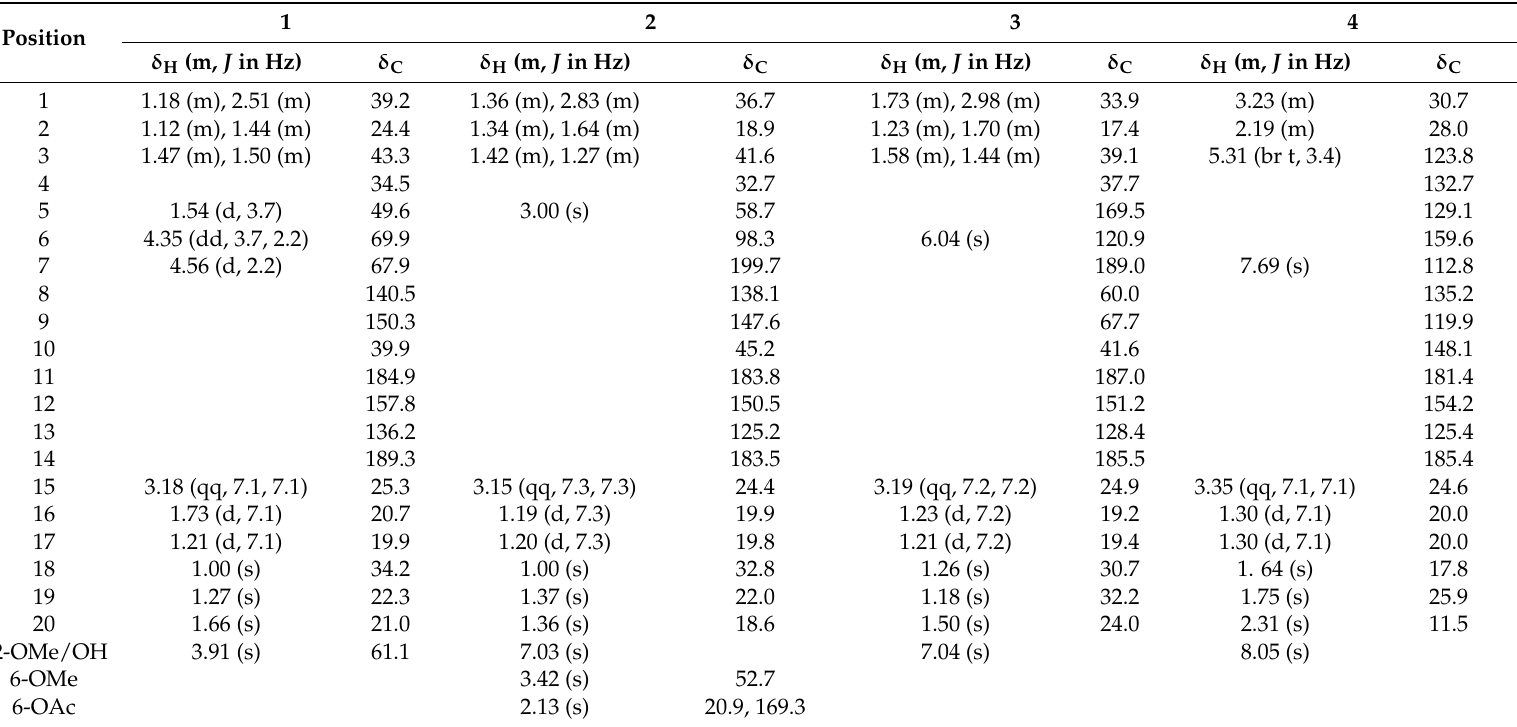
Table 1. 1 H (500 MHz) and 13 C (125 MHz) NMR data of compound 1 (in acetone- d 6 ) and compounds 2 – 4 (in CDCl 3